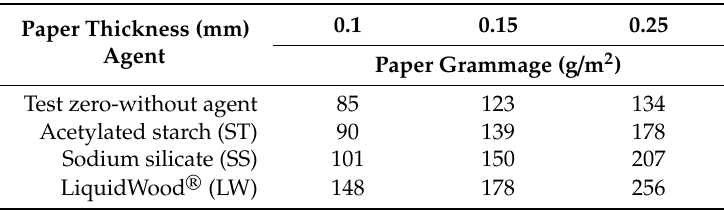
Table 1. Grammage of paper used.